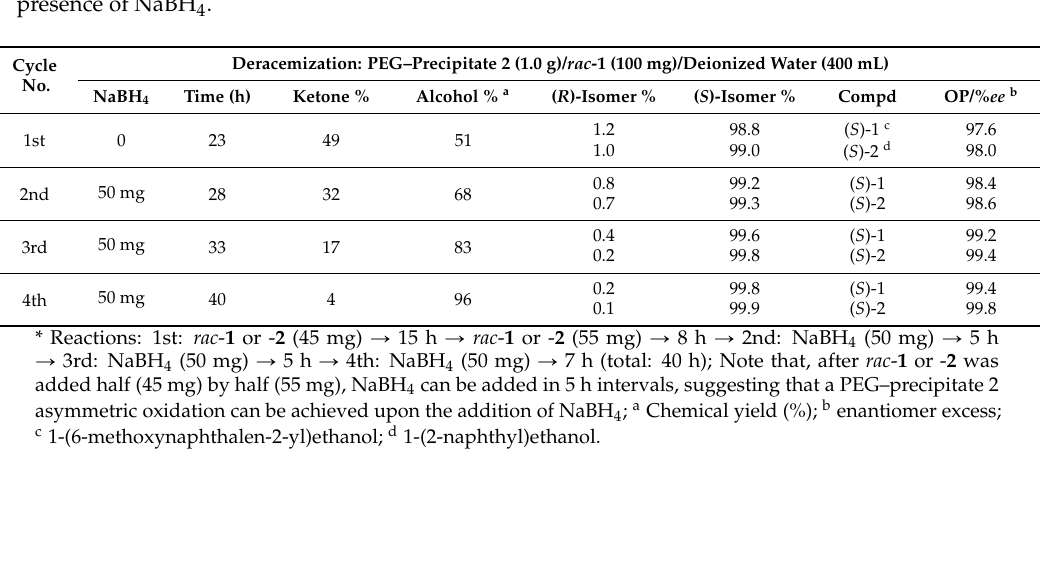
Table 3. Application of polyethylene glycol (PEG)–precipitate 2 to the cyclic deracemization in the presence of NaBH 4 .